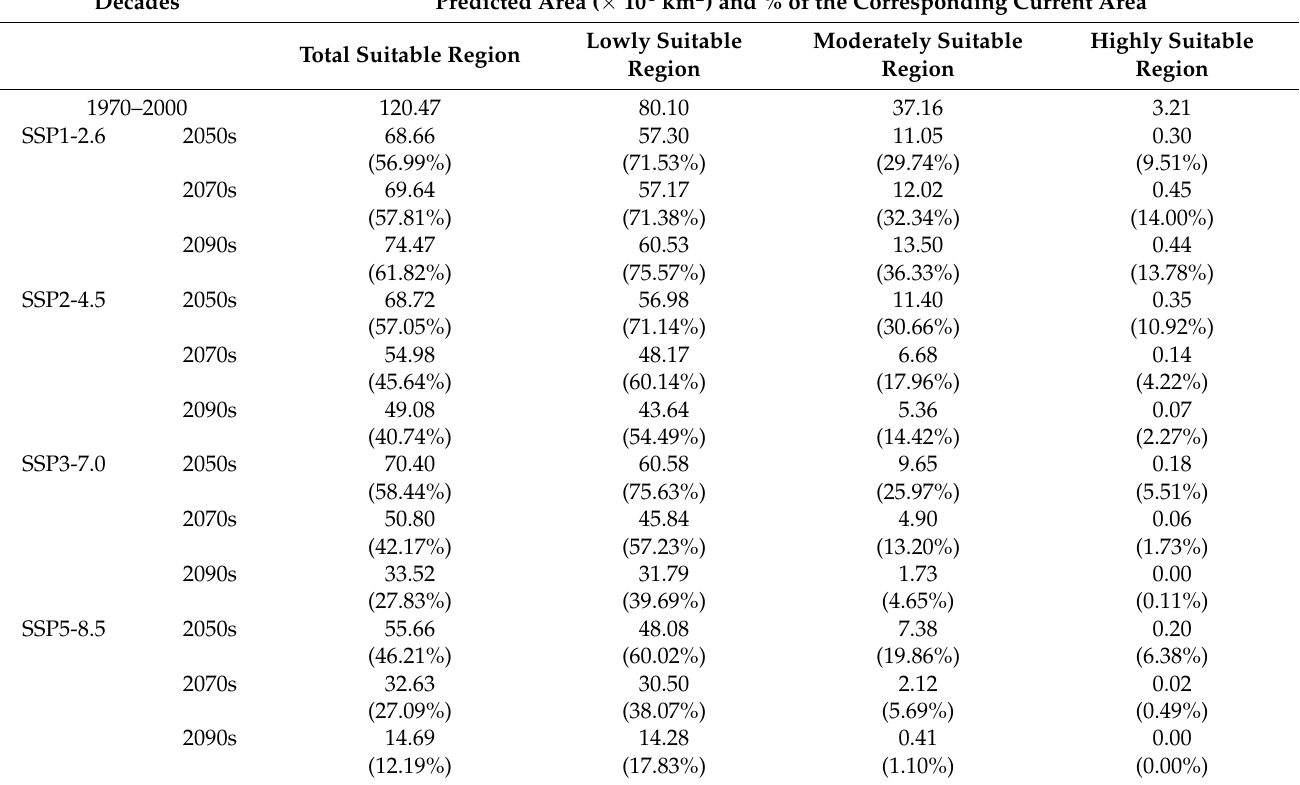
Table 2. Predicted suitable areas under current and future climatic